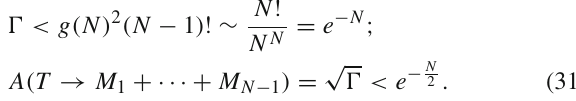
an excited quark. Multiplying by the factor 1 / N from the gluon interaction, we